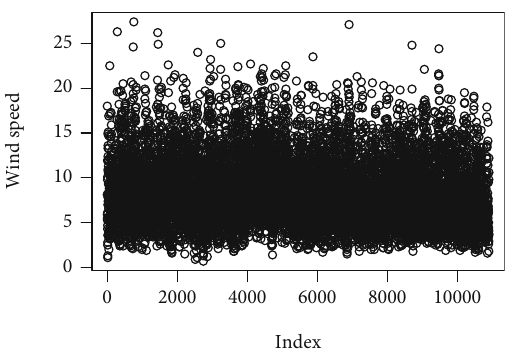
Figure 5: Scatter plot of the wind speed